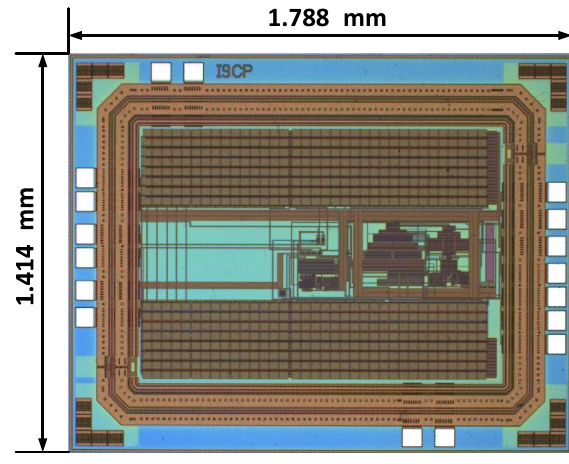
Figure 6. Micro-photograph of the charge pump.